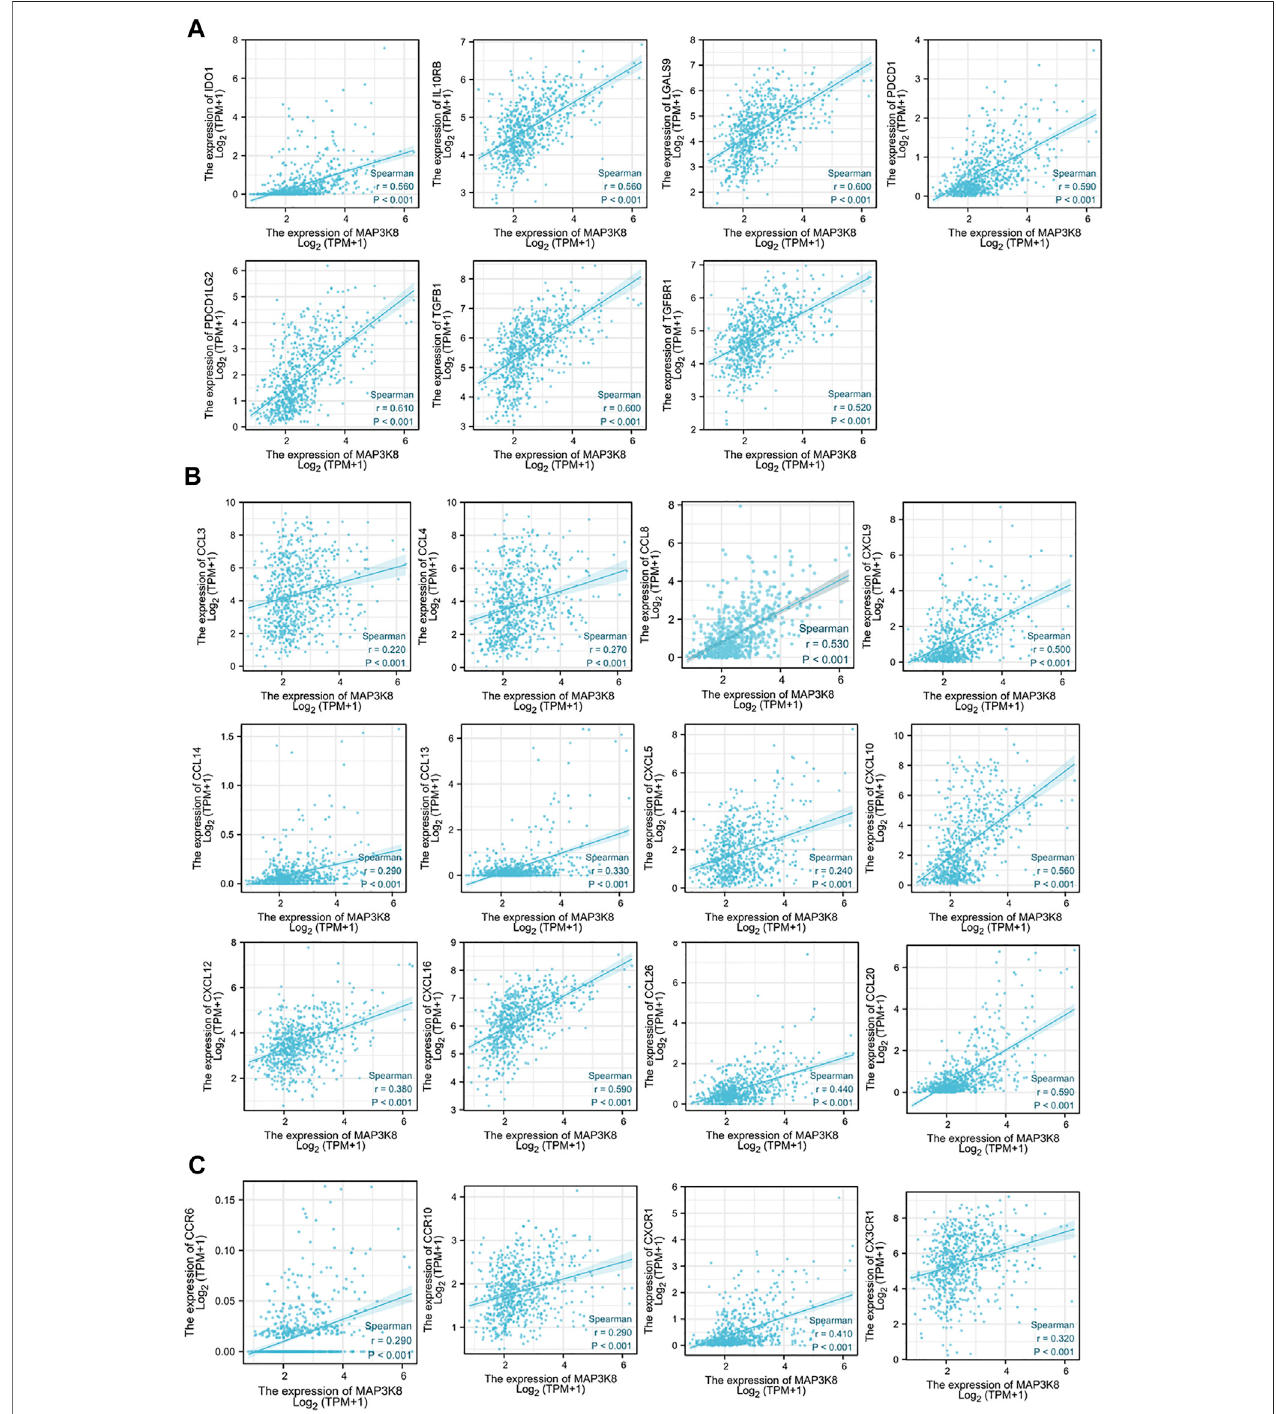
FIGURE 8 | Correlations of MAP3K8 expression with the expressions of immune inhibitors, chemokines, and chemokine receptors in The Cancer Genome Atlas (TCGA)dataset. (A – C) CorrelationsbetweentheexpressionsofMAP3K8andimmuneinhibitors (A) ,chemokines (B) andchemokinereceptors (C) ingliomafromTCGA dataset. The correlation analysis was evaluated by Spearman ’ s